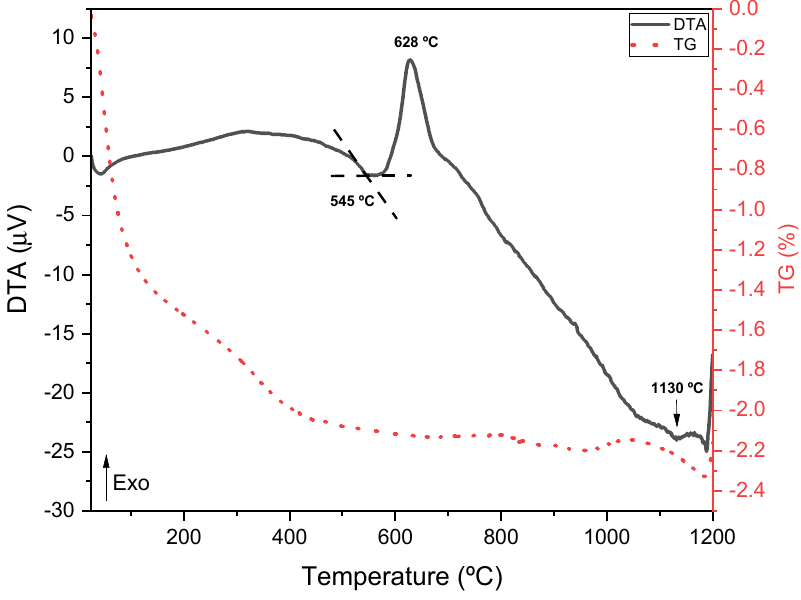
Figure 1. DTA-TG spectrum of the Ce2 sample at a heating rate of 5 ◦ C/min. To analyze the surface morphology of the bulk samples, scanning electron microscopy images were assessed (Figure 2). The 45S5 and Ce2 bulk samples show a characteristic morphology of glass without the presence of any crystalline phase.